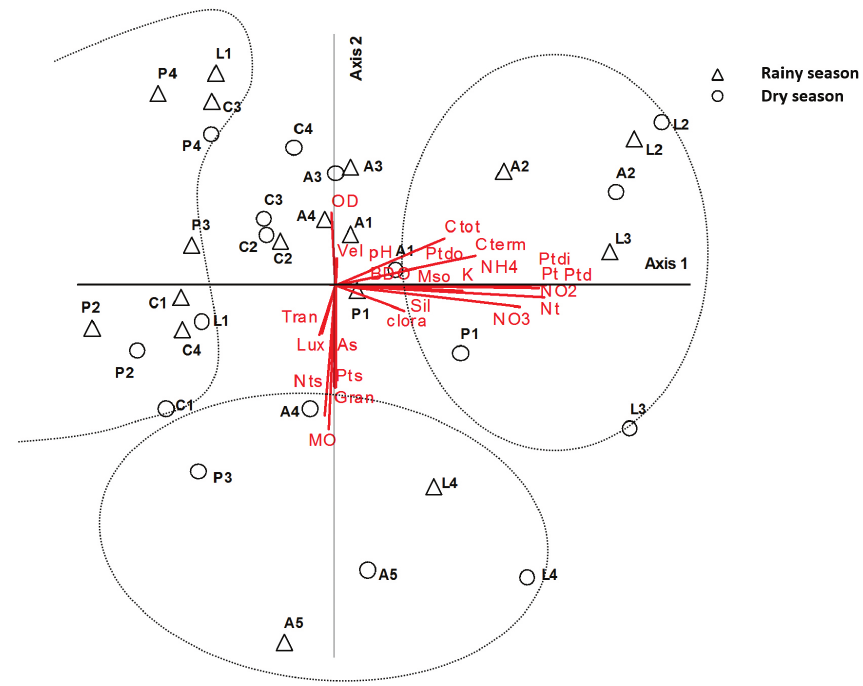
Figure 2. Principal component analyses of Araquá, Capivara, Lavapés and Pardo Rivers on the basis of studied vari- ables measured in rainy and dry seasons.